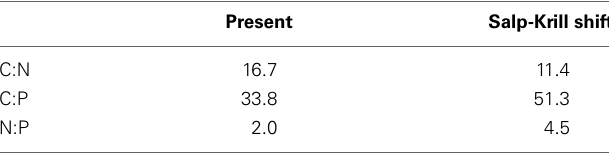
Table 6 | Average C R :N E , C R :P E and N E :P E metabolic quotients (atoms) for the whole zooplankton